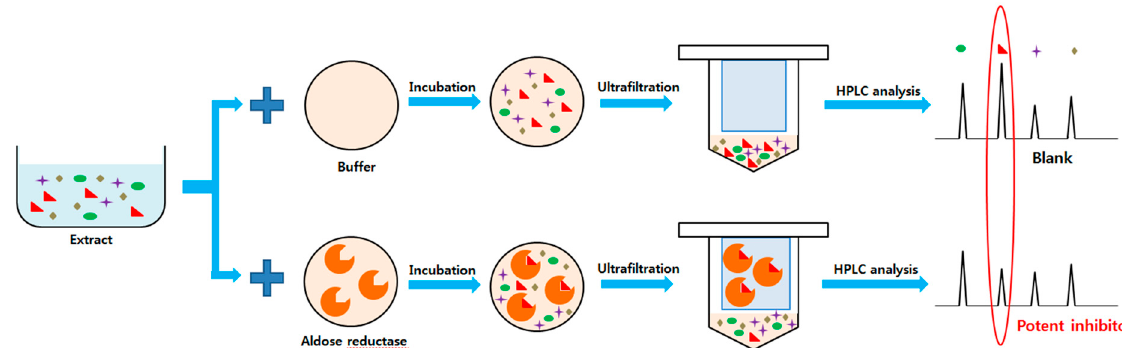
Figure 1. HPLC-based strategy for screening aldose reductase inhibitors from natural product extracts.